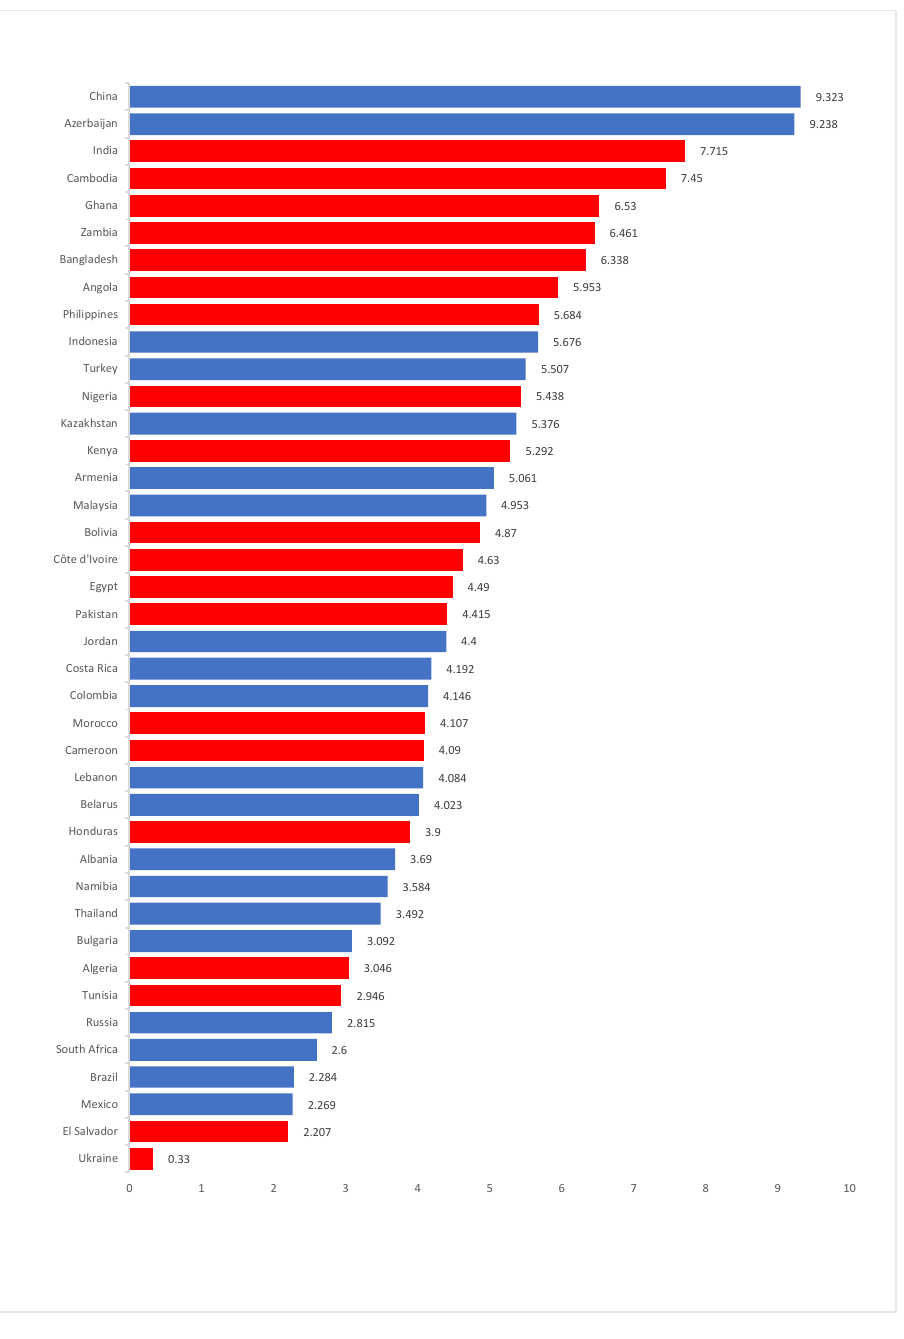
Figure 1: Average Real GDP Growth Rate within Middle Income Countries, 2005-2017; Source : Author’s computation using the Fiscal Monitor of the International Monetary Fund (IMF); Note: Blue bars denote upper middle-income countries and red bars signify lower middle-income